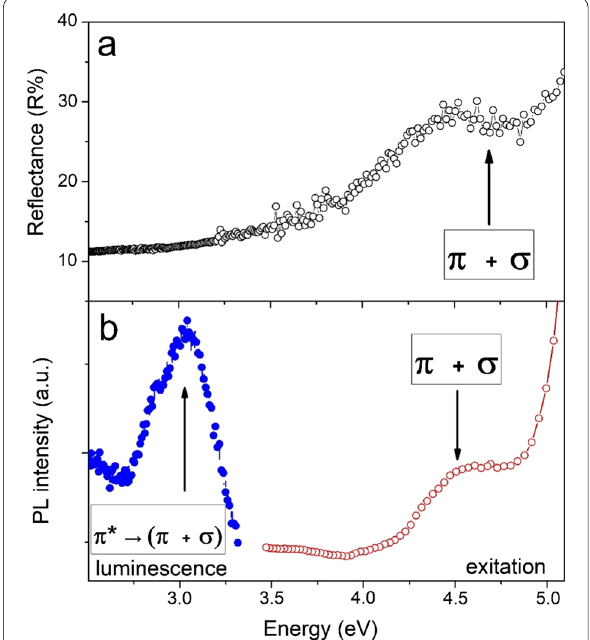
Fig. 6 Reflectance ( a ) and photoluminescence ( b ) spectra of CNF. The arrows indicate the contribution of ground π and exited π* states